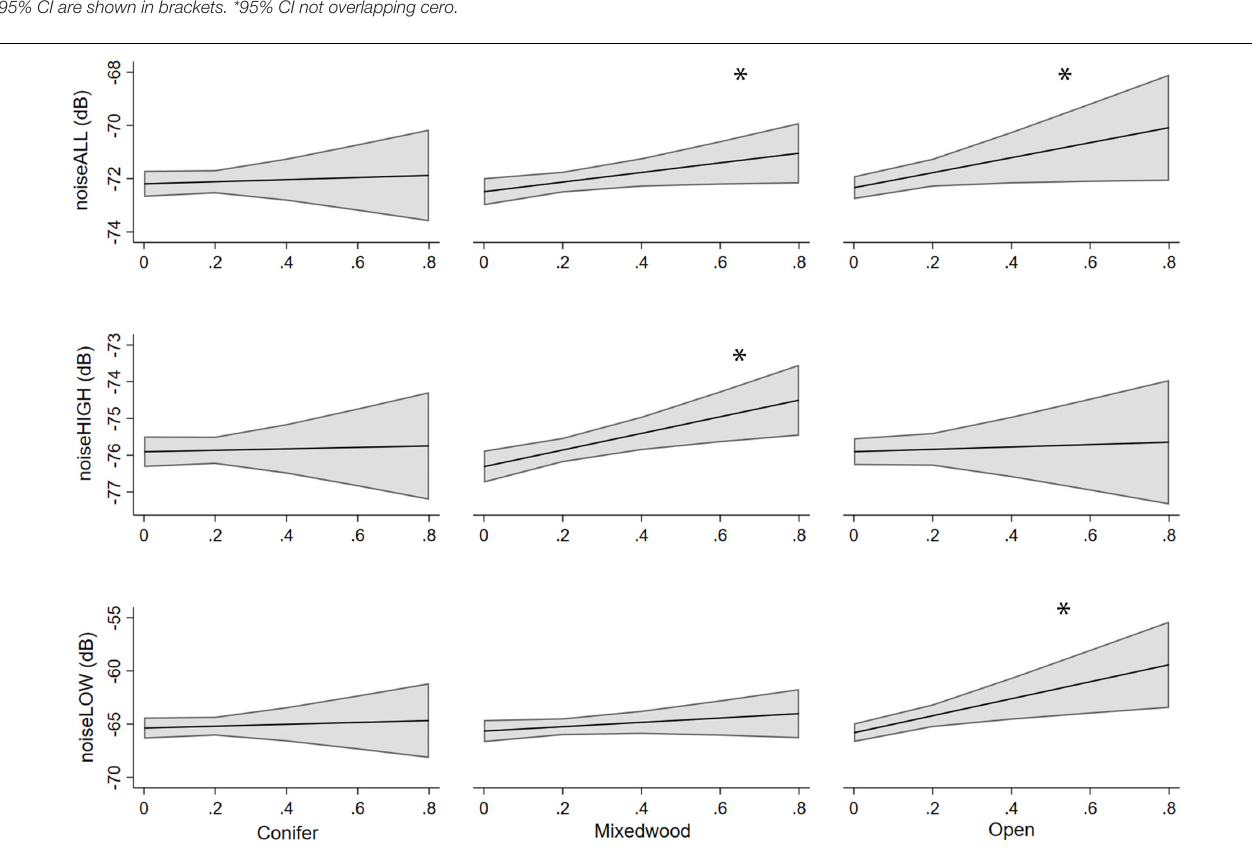
FIGURE 4 | Predicted noise levels from the three noise metrics with increasing proportions of conifer, mixedwood, and open habitats. Error bands are 95% confidence intervals. ∗ Indicates a significant